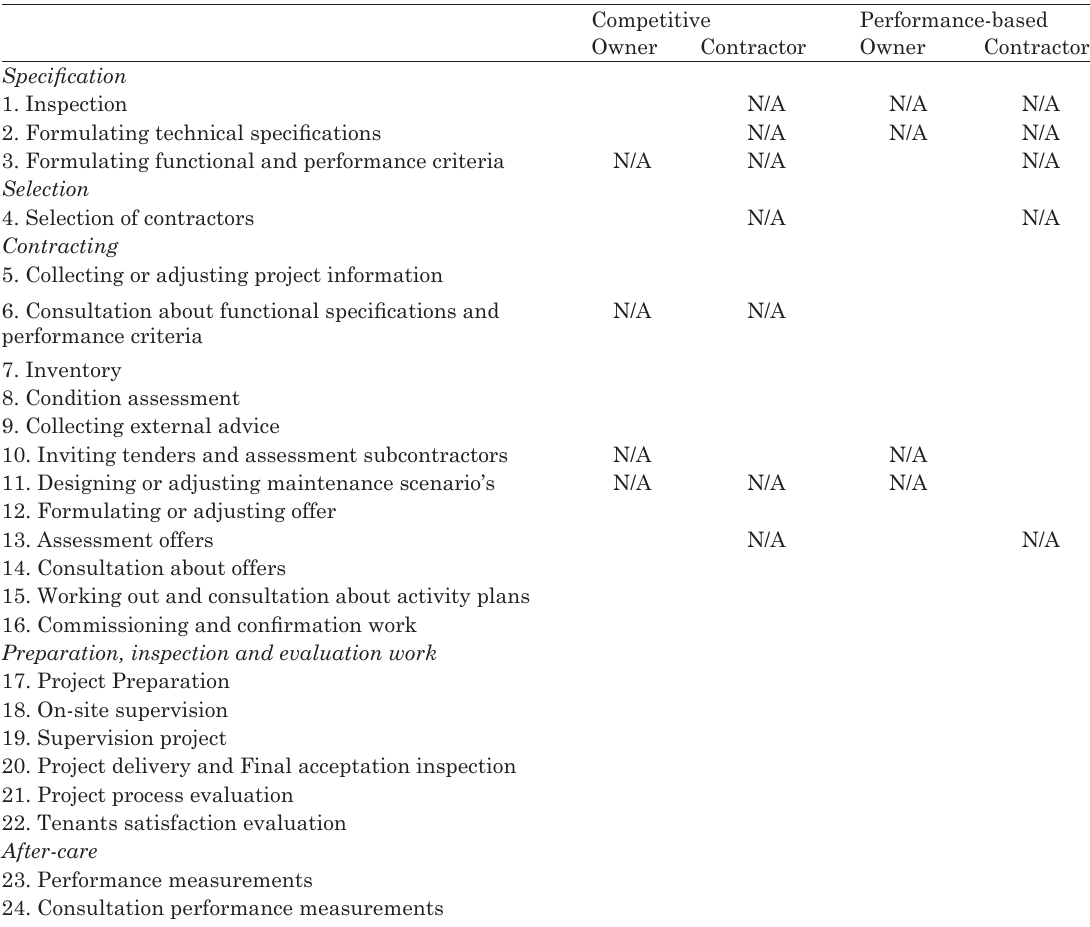
Table 2. Classification model for Indirect costs: time sheet for project time of the initial maintenance